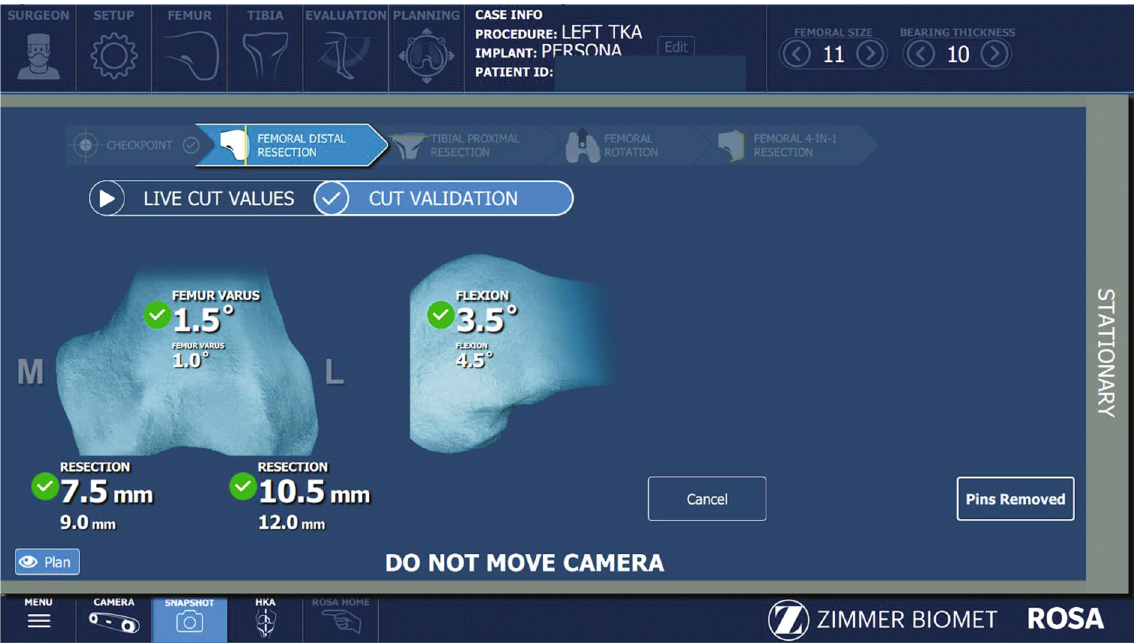
Figure 10: Final distal femoral resections validated against planned resections for Case